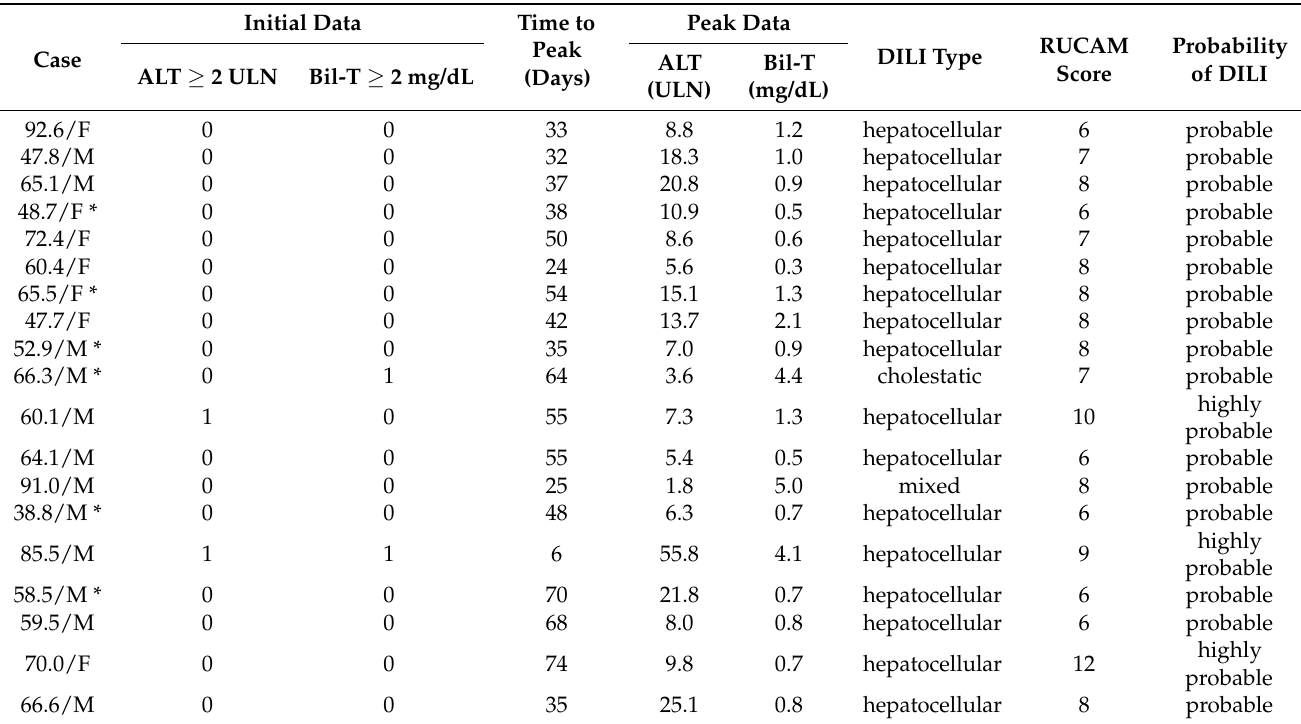
Table 2. Initial and peak liver profile as well as the Roussel Uclaf Causality Assessment Method (RUCAM) score of the 19 cases with drug-induced liver injury